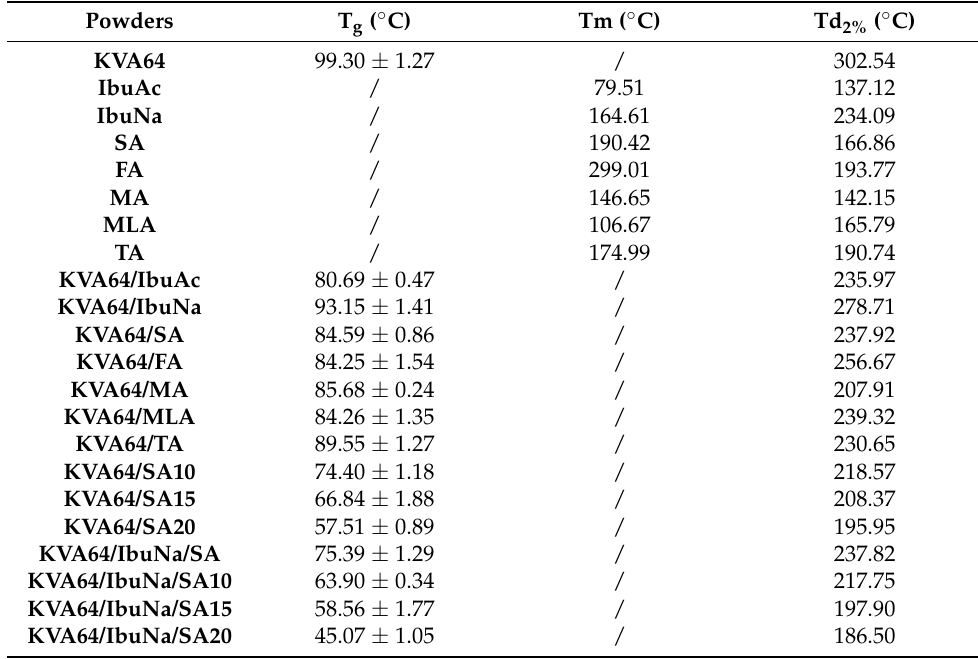
Table 3. Thermal properties of the different components and